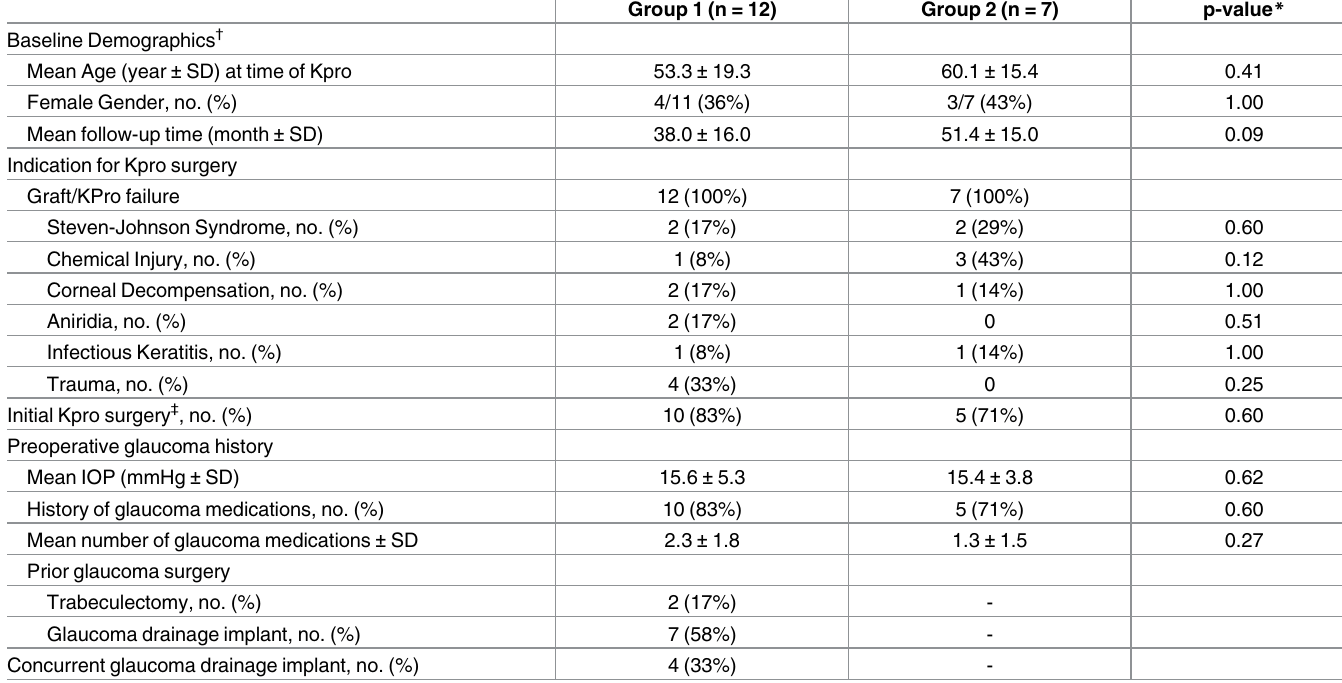
Table 1. Baseline characteristics of patients with Boston type I Keratoprosthesis with or without prior or concurrent glaucoma surgical